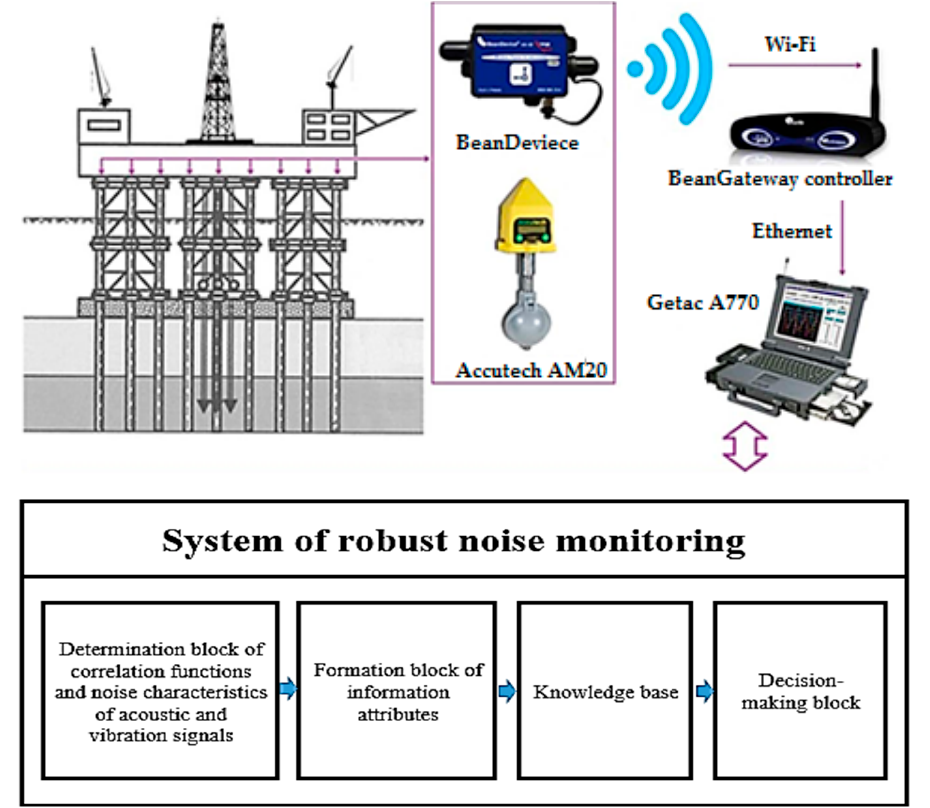
Figure 12. Block diagram of the noise monitoring system [52].